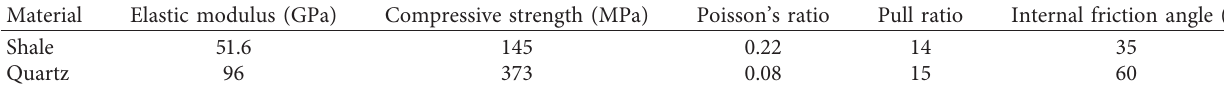
Table 1: Mechanical parameters of shale matrix and quartz minerals.